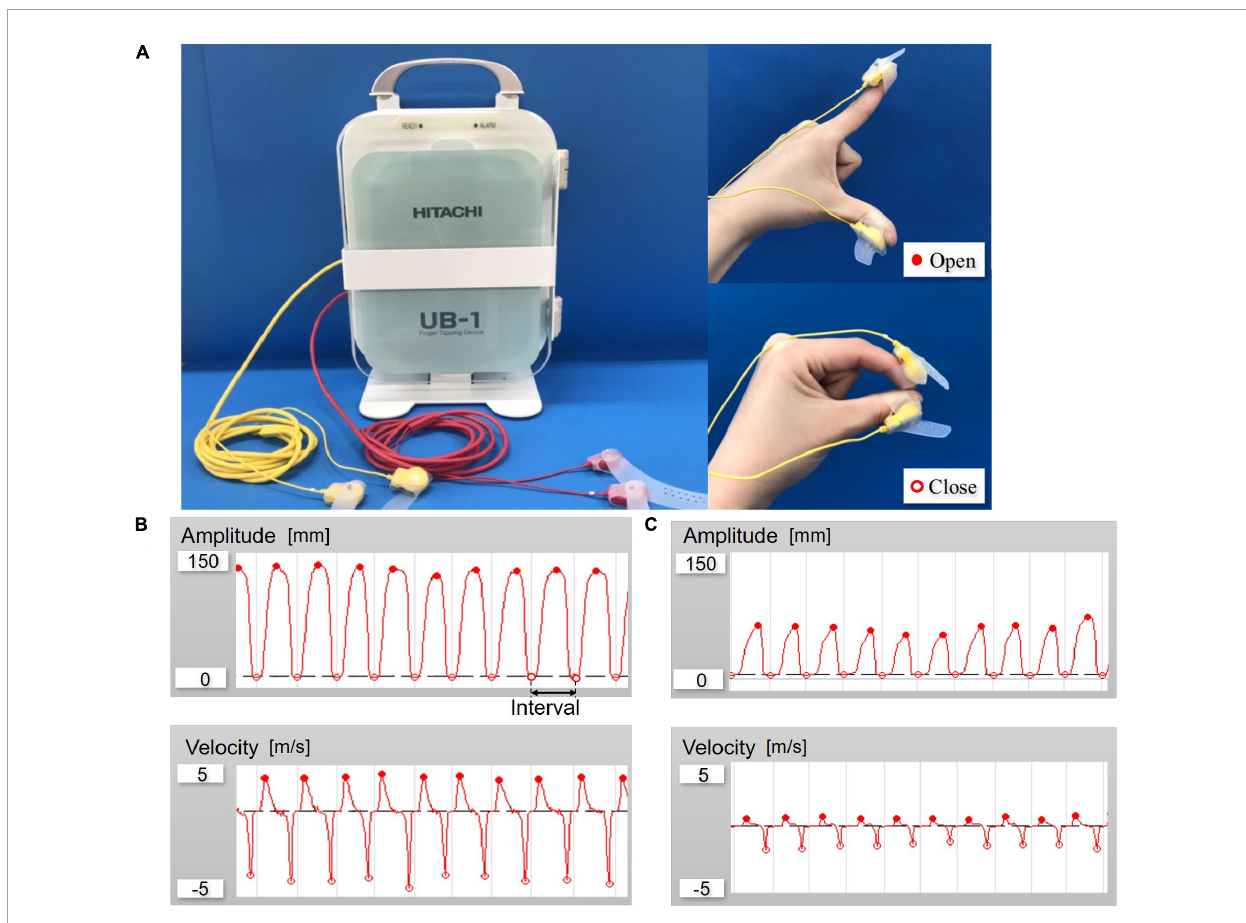
FIGURE1 (A) Overall view of UB-1; Finger-tapping system with magnetic sensors and finger tap. (B) Example of waveforms control. (C) Example of waveforms patient with idiopathic normal pressure hydrocephalus (iNPH) (amplitude and